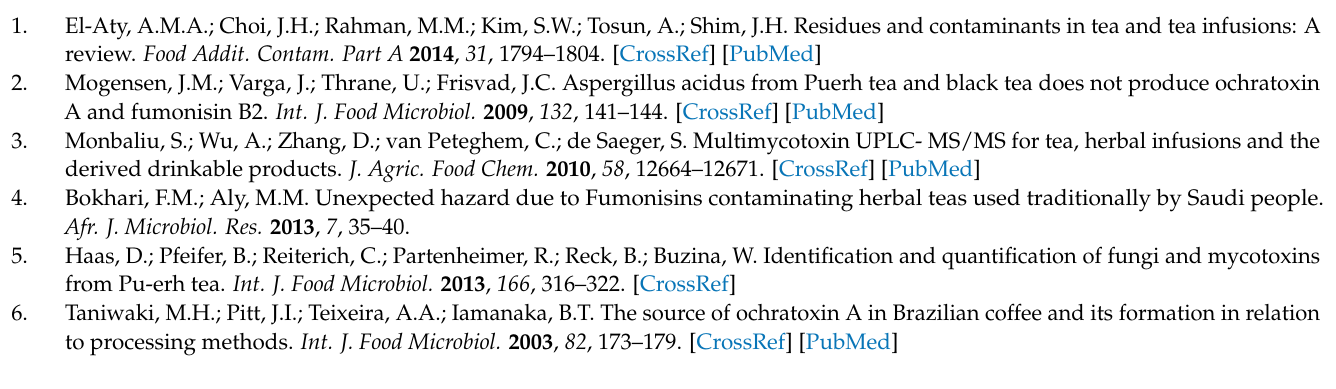
alcohol. Figure S2: Effect of various pH mediums for the extraction of Ochratoxin A from coffee, tea, and soil samples. Extraction conditions: 250 mg coffee, 2.0 mL solvent (under different pH conditions), 2.5 min of vortex extraction, and clean-up under the flow rate of 0. 5 mL/min using 1000 mg MgSO 4 , 75 mg AC and 50 mg C18 with three replicative